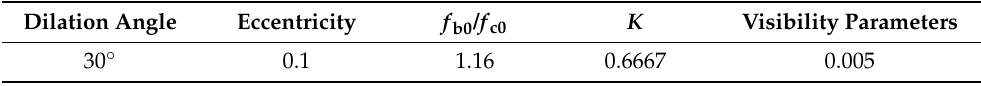
Table 1. Plastic damage model parameters of concrete. Dilation